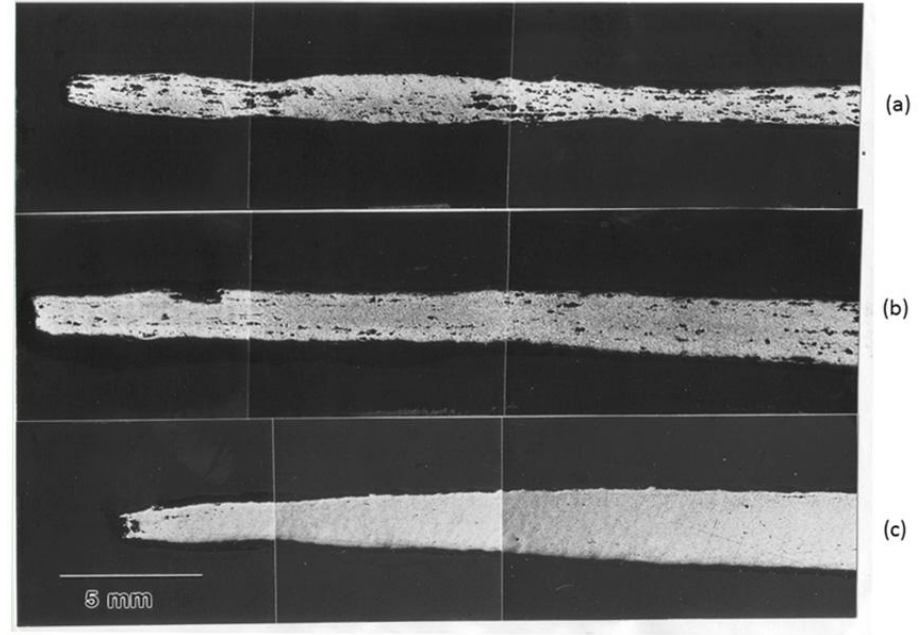
Figure 4. Cavitation in Zn-22% Al grades at a strain rate of 1.33 × 10 −5 s −1 . ( a ) grade 1 (180 ppm of impurities); ( b ) grade 2 (100 ppm of impurities); and ( c ) grade 3 (6 ppm of impurities).